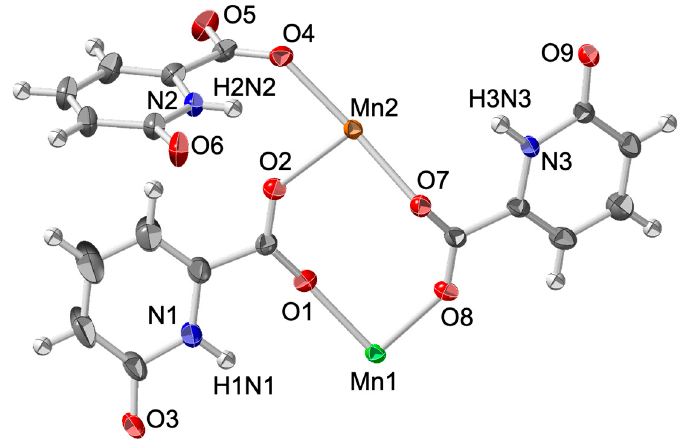
Figure 1. ORTEP diagram of the asymmetric unit with labelling scheme of compound 1 . Ellipsoids are drawn at 50% probability (except the H atoms).